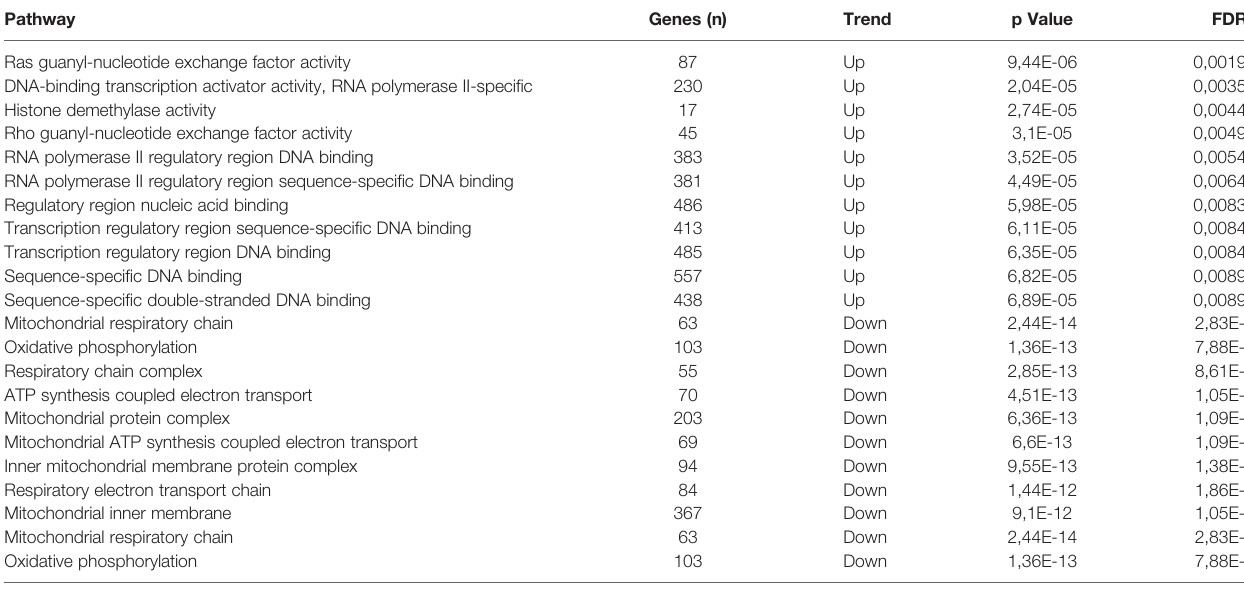
FDR, False discovery